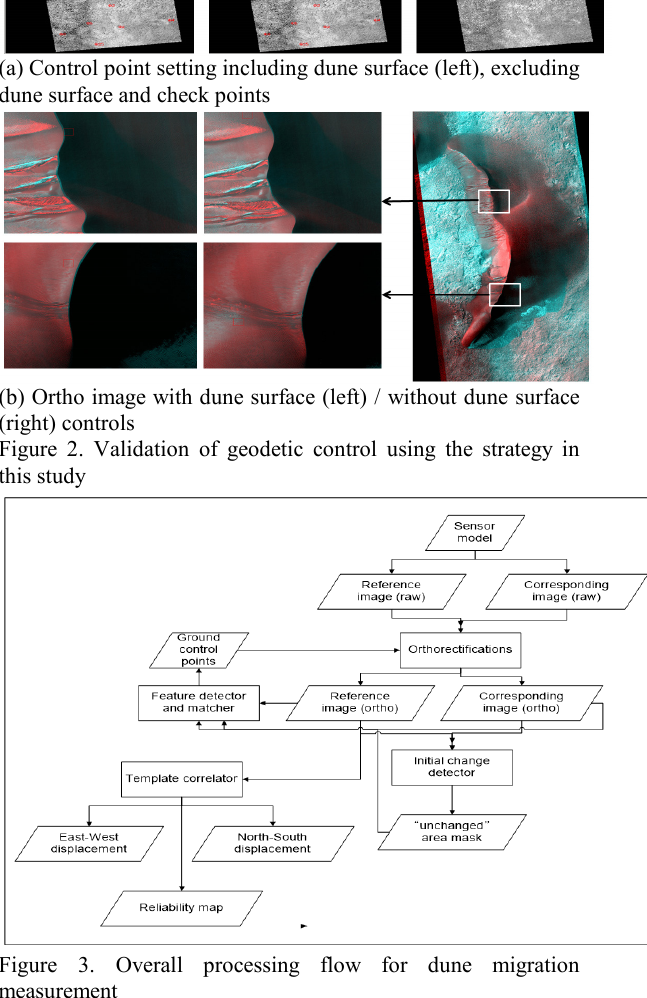
Figure 3. Overall processing flow for dune migration